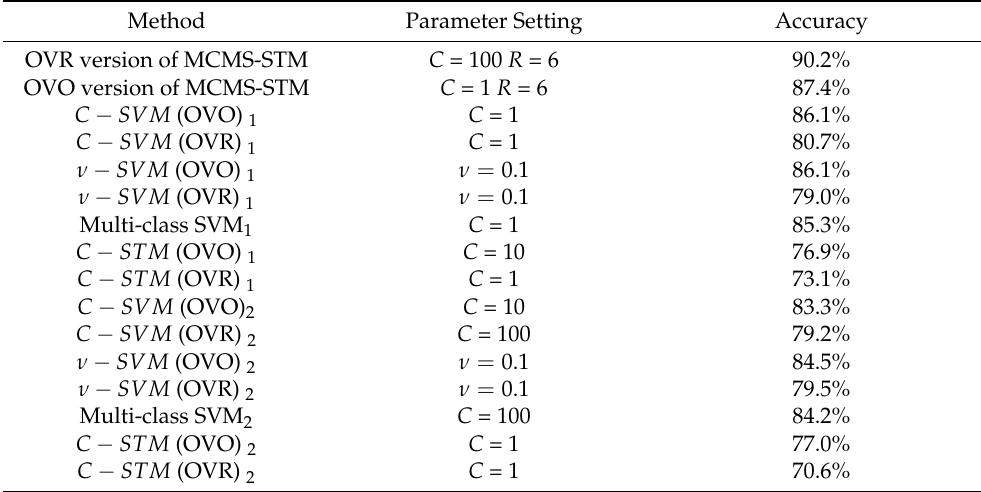
Table 5. The accuracies of different methods for multiscale ships recognization using 5-fold cross- validation.